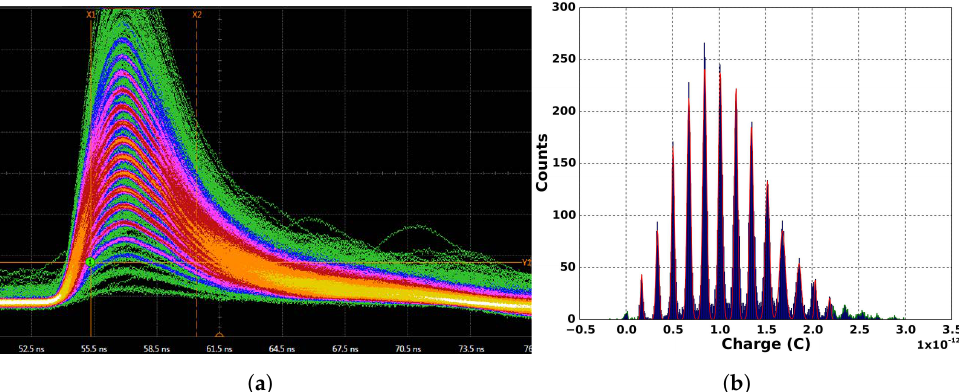
Figure 10. Individual analog output with the default PZ cancellation at low level illumination using the Hamamatsu SiPM S13360 − 3075CS at 5 V of over − voltage. ( a ) Analog output pulses with a FWHM of 5 ns; ( b ) Charge